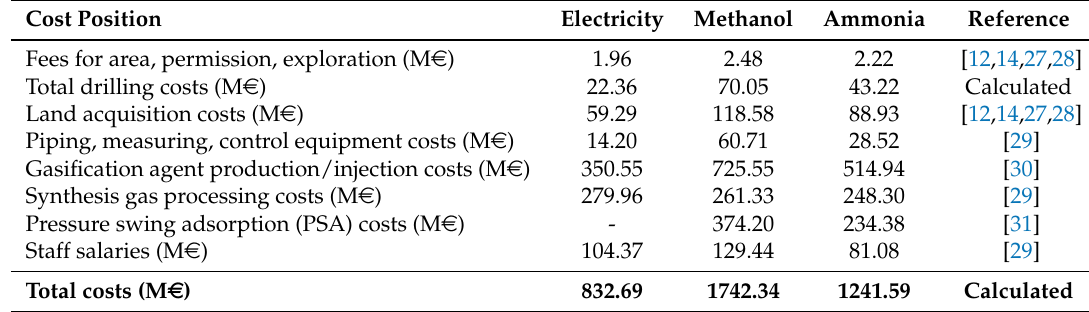
Table 4. Total onshore UCG costs for a 20-year operation of onshore electricity, methanol, and ammonia production